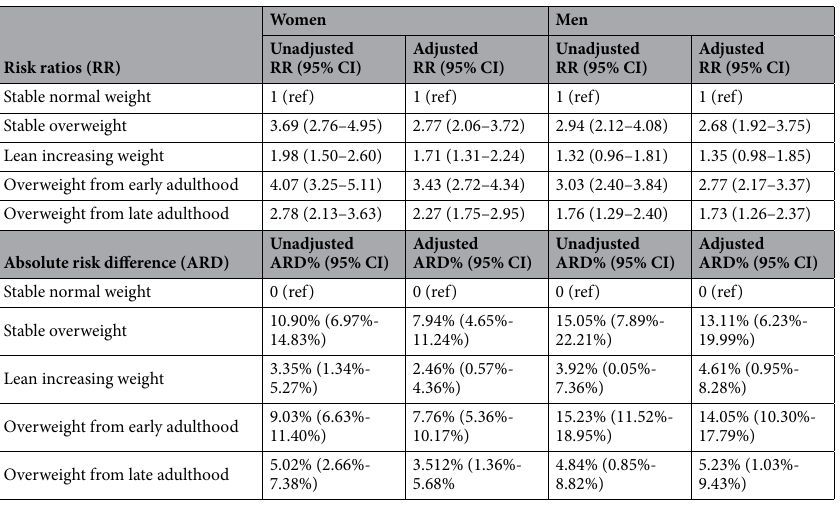
Table 3. Association between life-course trajectories of weight categories and cumulative incidence of type 2 diabetes. Models for males and females were estimated separately. Covariates included in the adjusted model for were age, family history of type 2 diabetes, general health, comorbidities, self-reported physical activity, smoking, and alcohol consumption for both sexes and history of gestational diabetes for women. Adjusted absolute risk differences were estimated using the mean of all covariates.